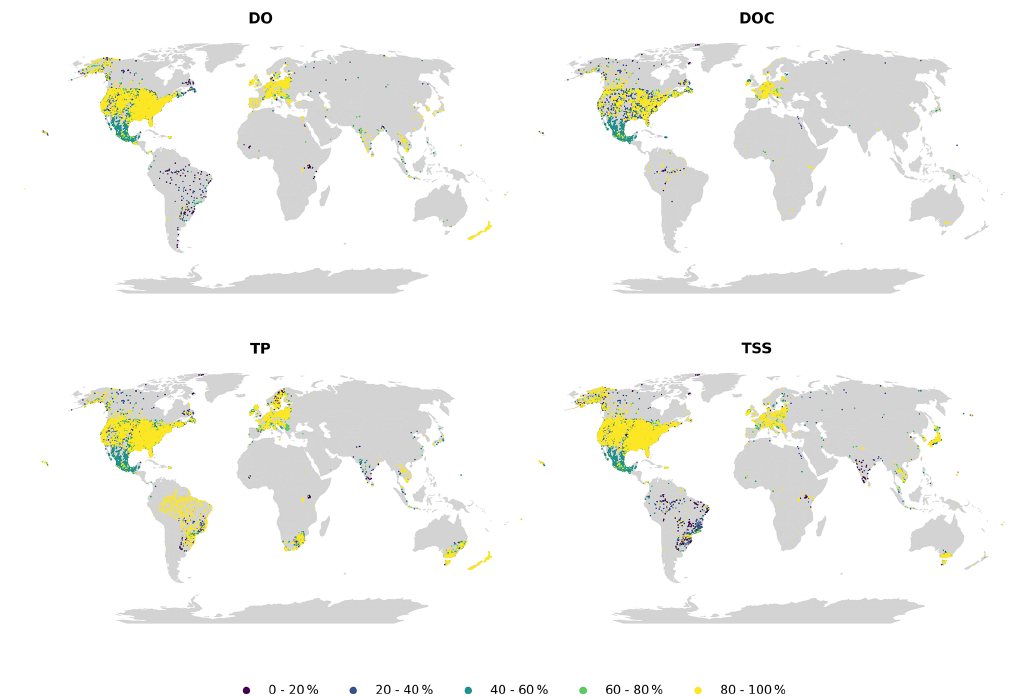
Figure 5. Monthly availability for dissolved oxygen (DO), dissolved organic carbon (DOC), total phosphorus (TP) and total suspended solids (TSSs).